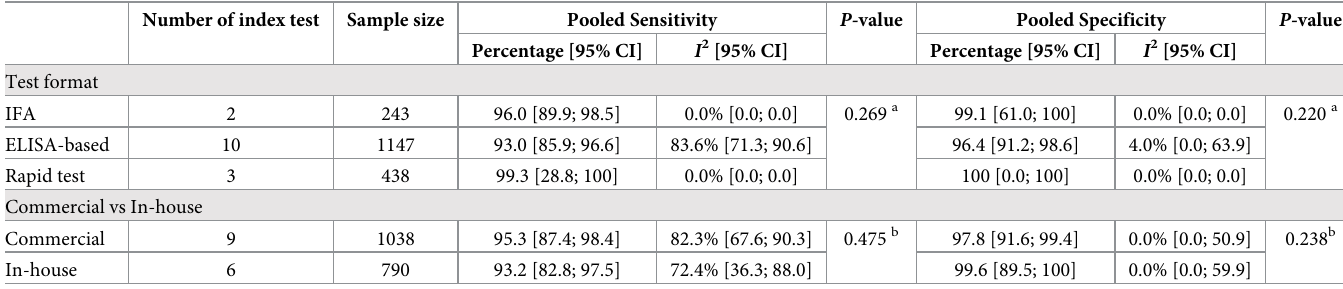
Table 8. Analysis for IgG detection tests.